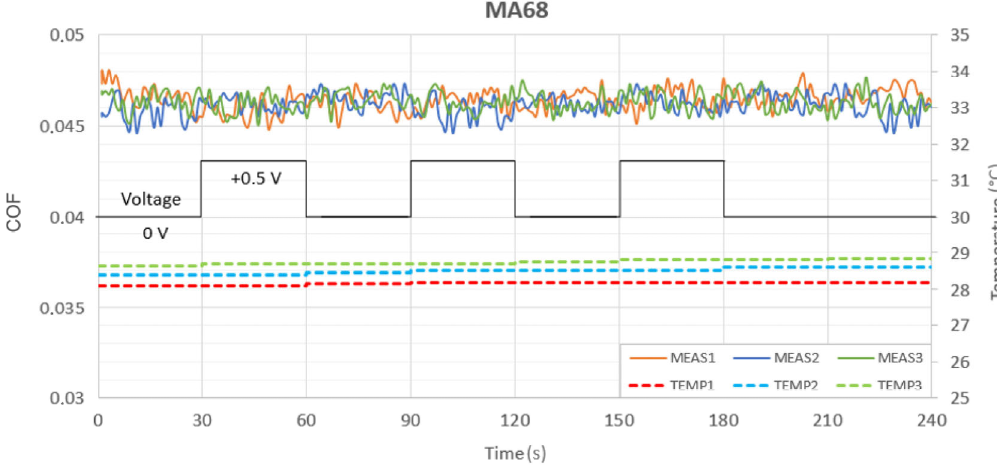
Fig. 7 MA68 oil COF and temperature dependence on voltage change.